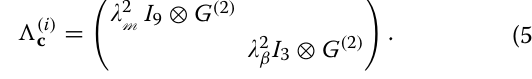
(cid:31) m for each (cid:31) β